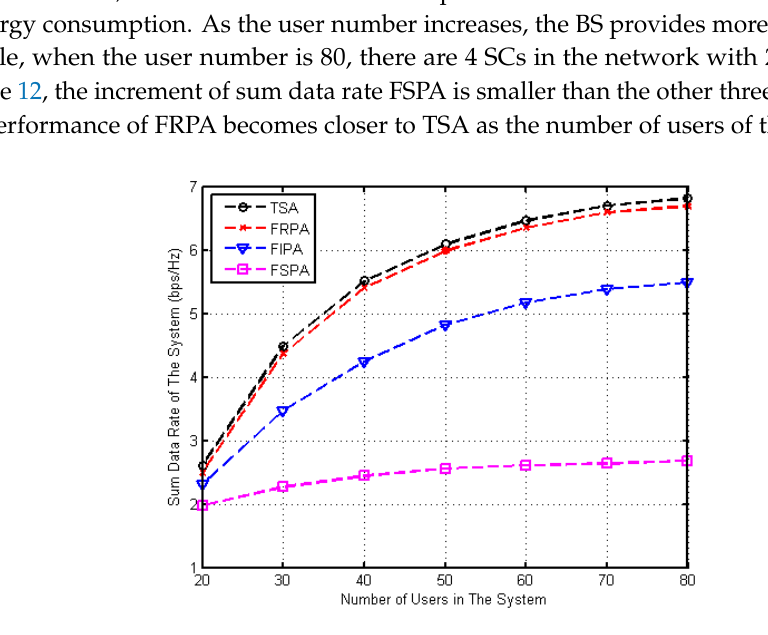
Figure 12. Plot of the sum data rate of the system versus the number of users.